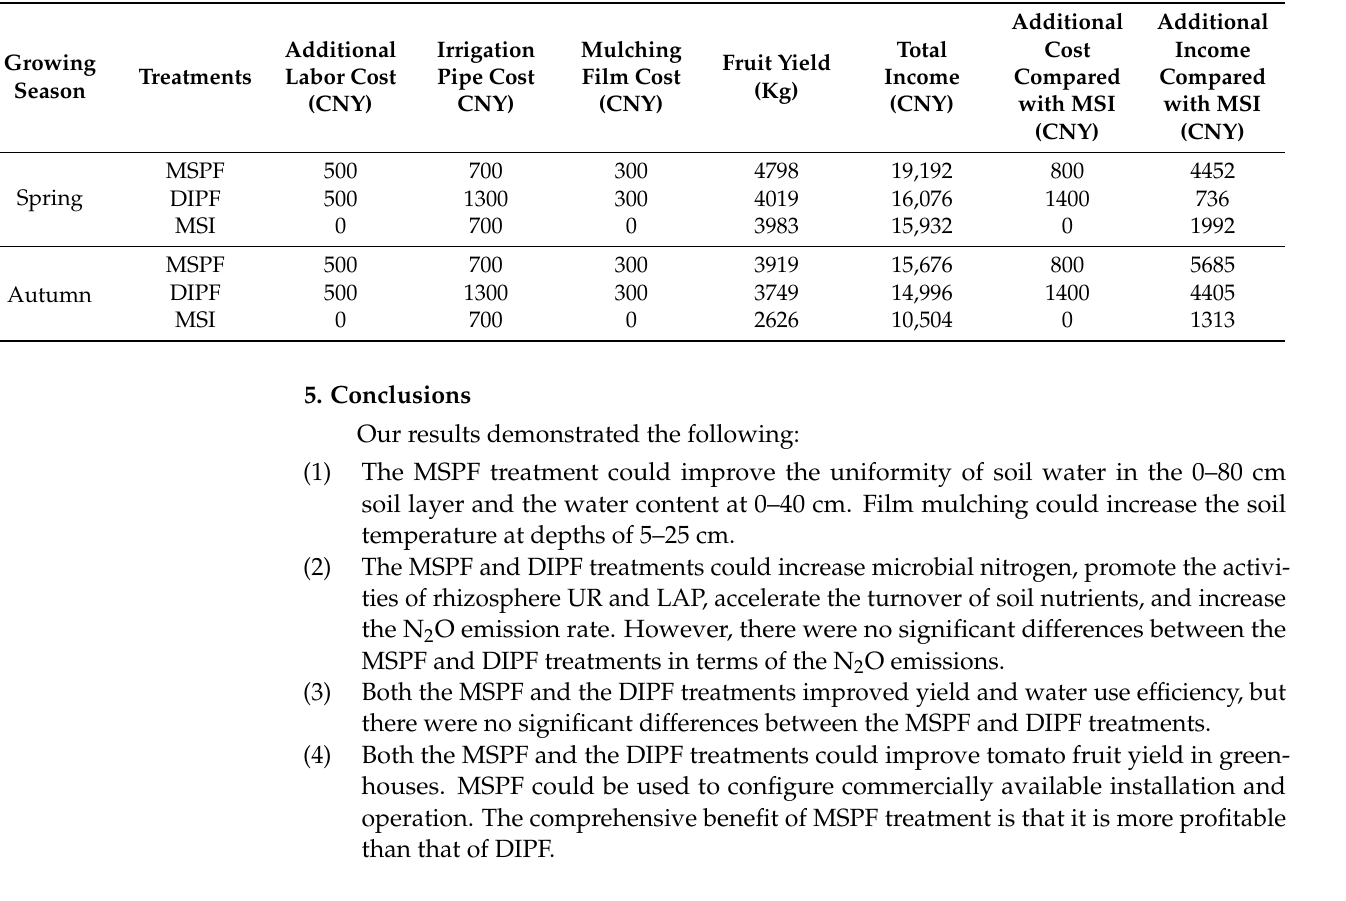
Table 4. Economic effectiveness of irrigation strategies and plastic film mulching in each